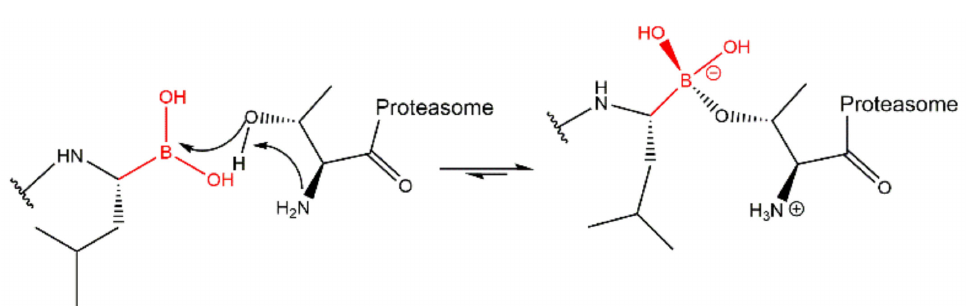
Figure 8. Examples of boronate inhibitors of 20S CP [31,37,38].